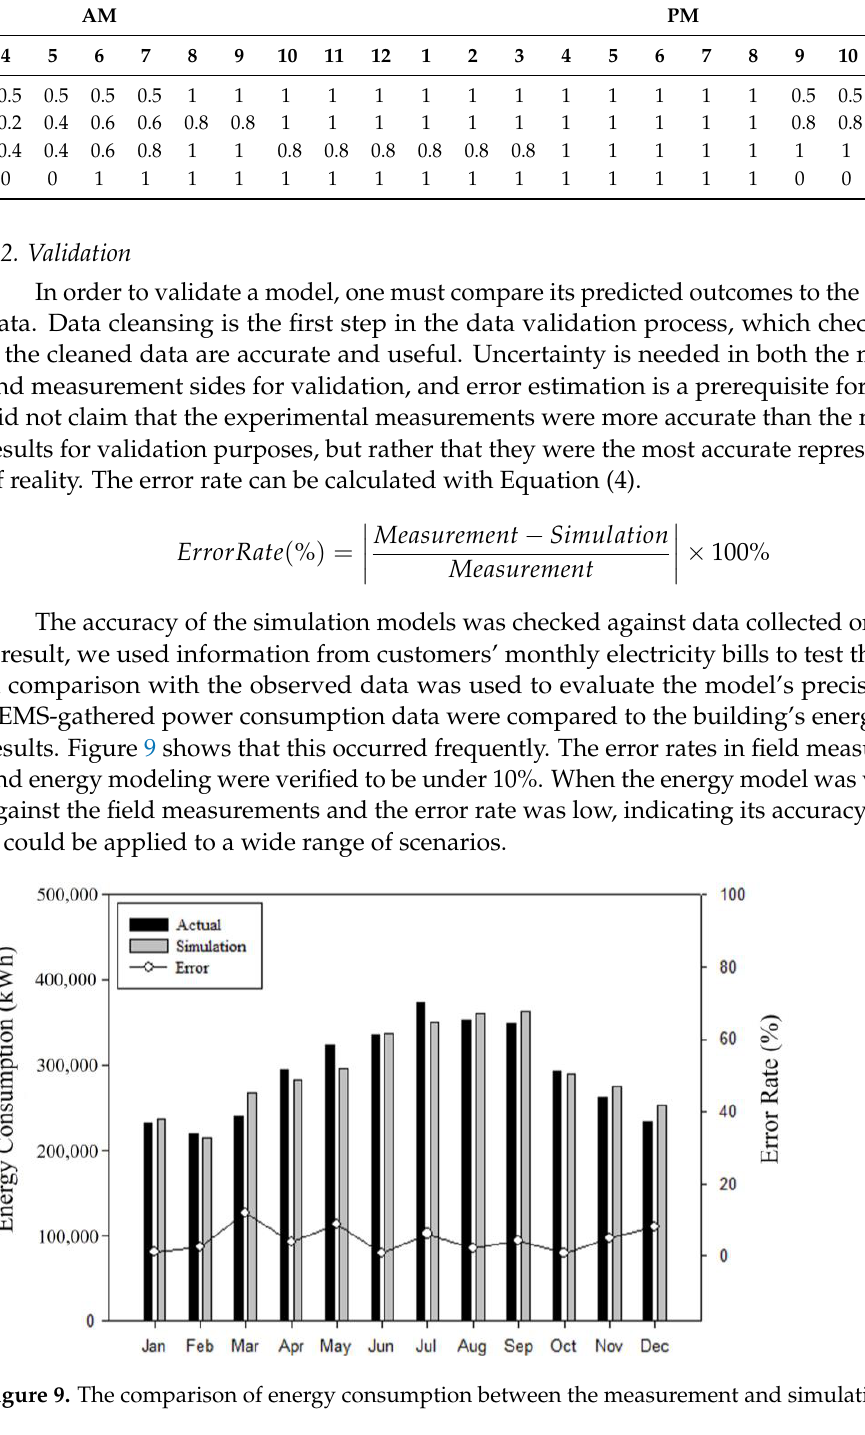
Table 6. Building schedule and operation time.